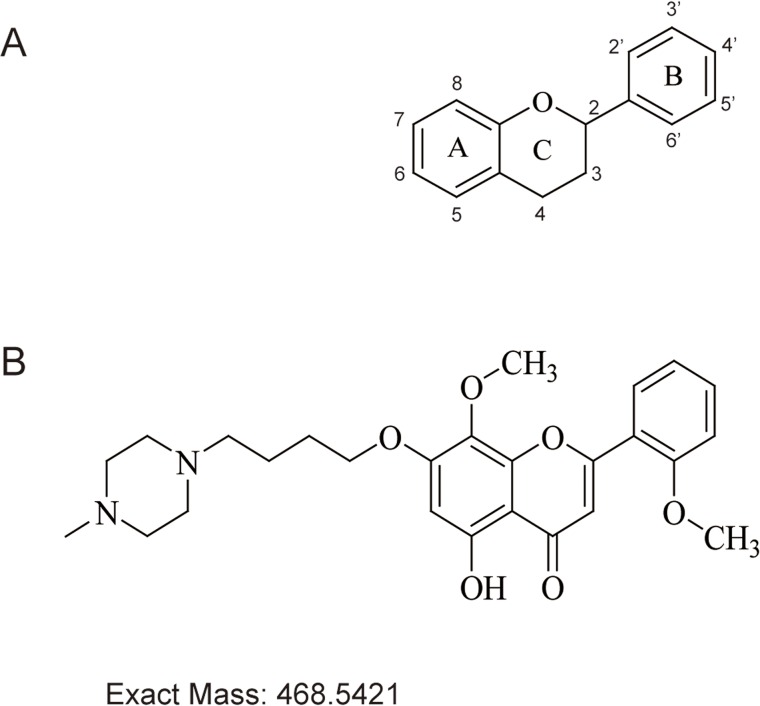
The chemical structures of flavone and LZ-207.(A) Chemical structure of the 15-carbon flavone backbone. (B) Chemical structure of LZ-207 (C26H32N2O6, MW = 468.5421).